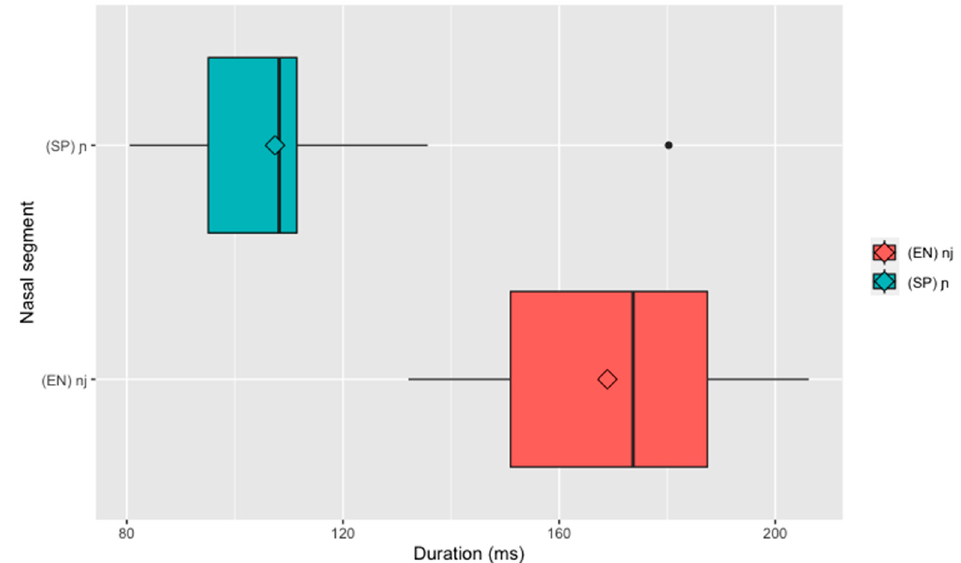
Figure 4. Duration of the following vocalic portion of /n+j/ produced in English mode and / ɲ / produced in Spanish mode Note: “Nasal segment” refers to / ɲ / and /n+j/; diamonds represent duration means.